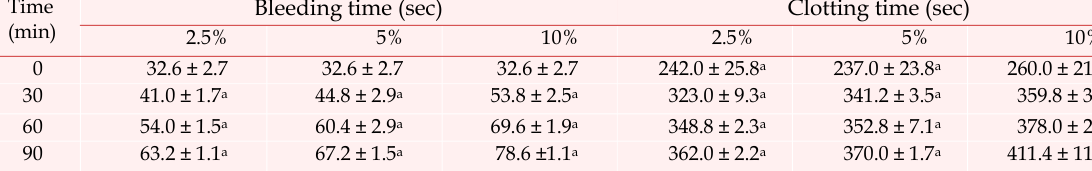
Effects of B. orthobotrys extract on in vivo bleeding and cloting times in